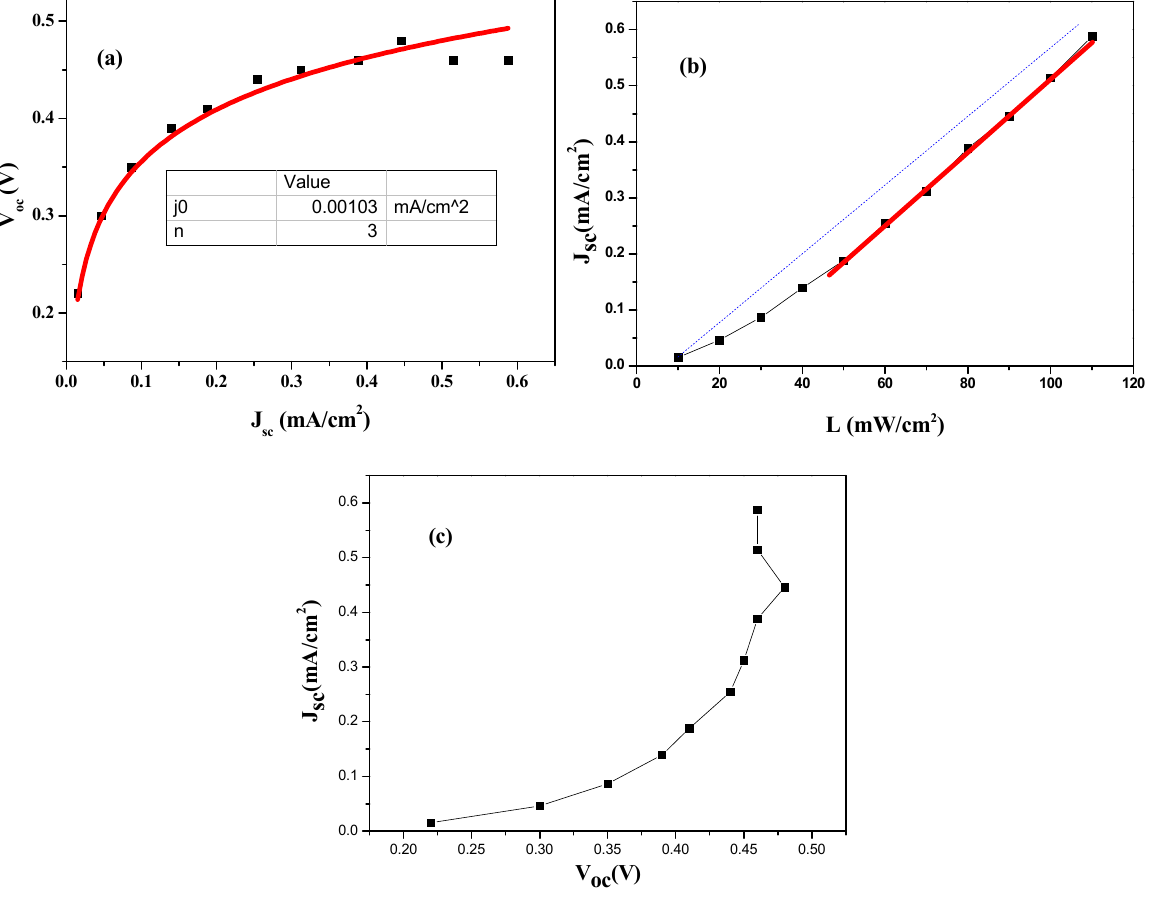
Figure 7. Photovoltaic performance parameter of HTS based QDSSC ( a ) V oc − J sc ; ( b ) J sc – L ; ( c ) J sc − V oc